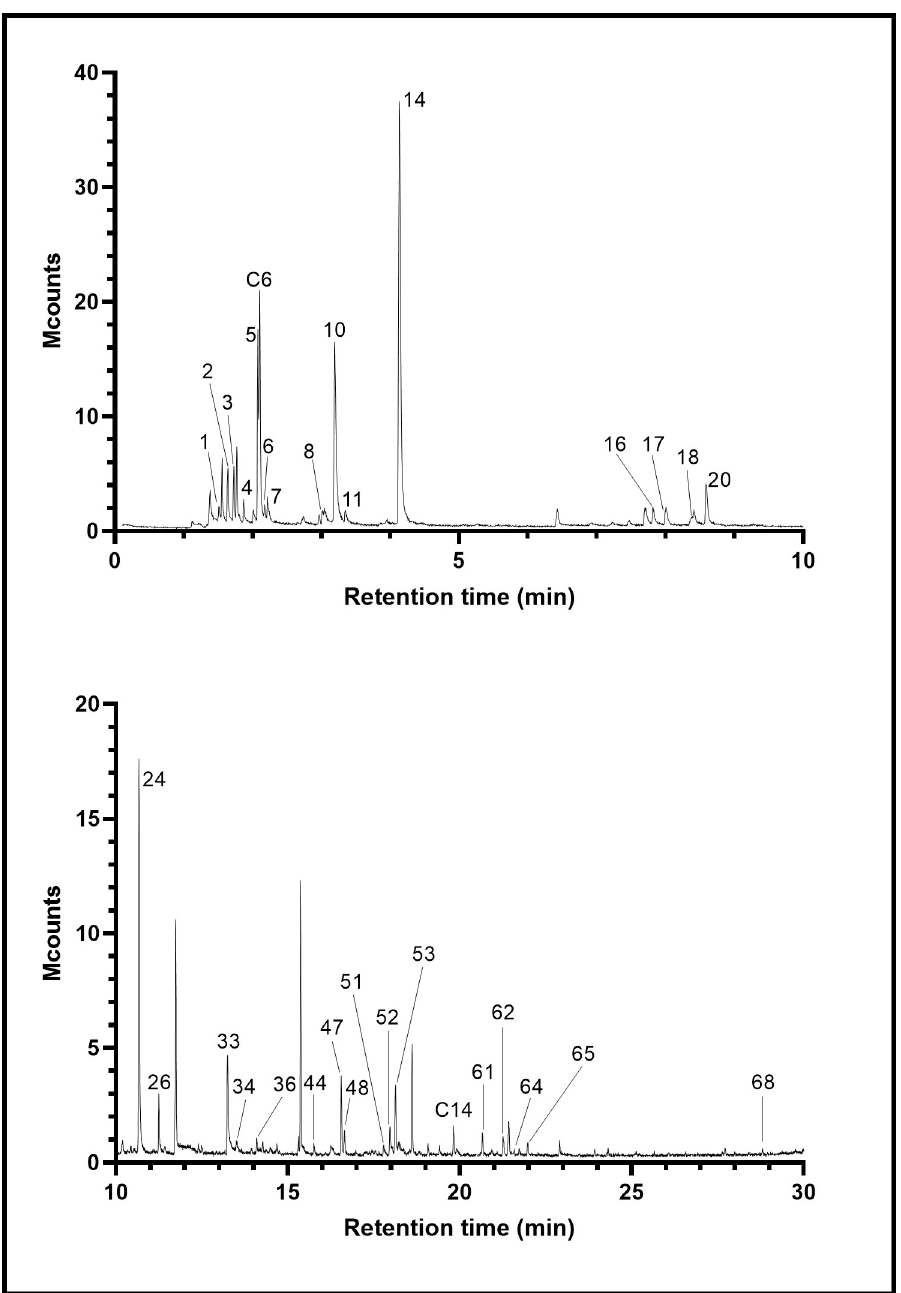
Fig 1. SPME-GC-MS analysis of urine of a male fox (no. 6). The peak numbers refer to compounds in Table 1, and C6 and C14 are hexane and tetradecane, respectively (both artifacts). Unlabelled peaks are fibre-related or other